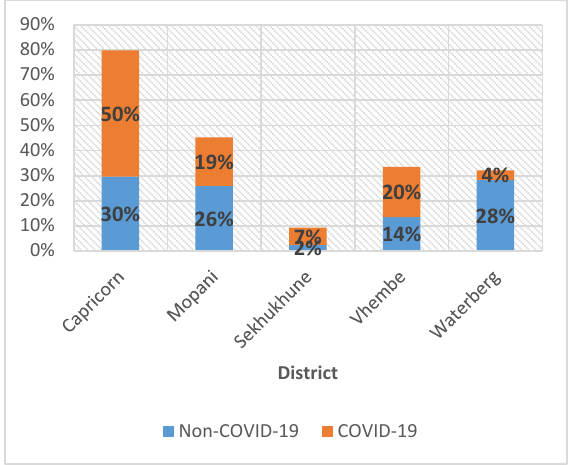
Figure 2. Prevalence of mortality among individuals with laboratory-confirmed SARS-CoV-2 ac- cording to districts ( p –value < 0.001).